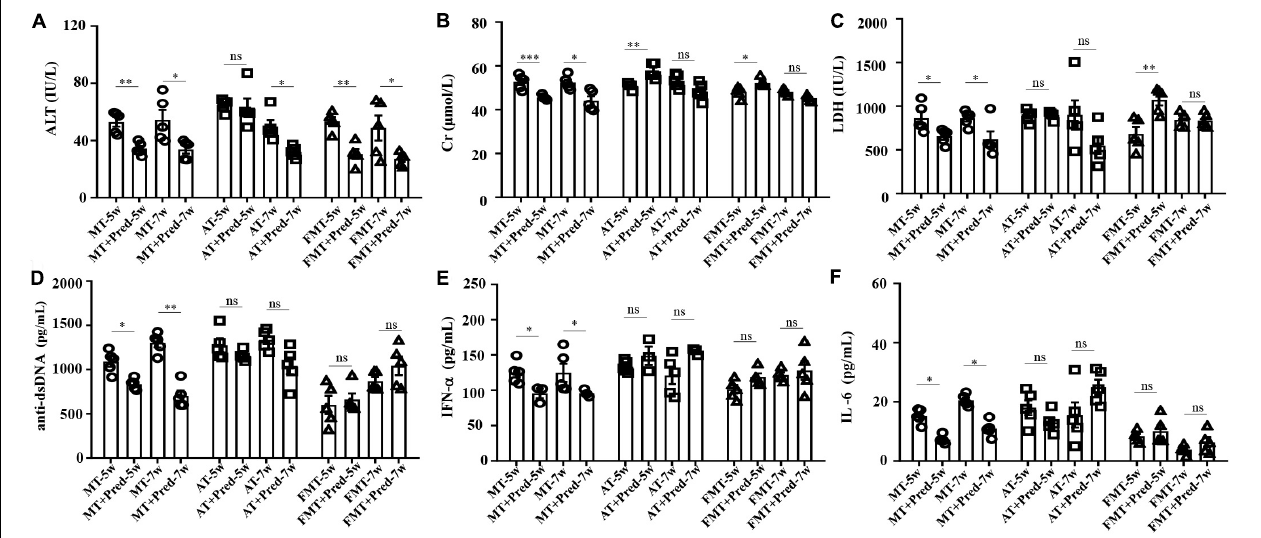
FIGURE 4 | Prednisone-induced alterations in serum levels of alanine aminotransferase activity (A) , creatinine (B) , lactate dehydrogenase activity (C) , anti-double stranded DNA antibody (D) , interferon- α (E) and interleukin-6 (F) in MRL/lpr mice from three groups. NC, The C57/BL6 mice treated with PBS solution from 6 to 9 weeks old; MT, the MRL/lpr mice treated with PBS solution from 6 to 9 weeks old; AT, the MRL/lpr mice treated with antibiotics from 6 to 8 weeks old and PBS solution from 8 to 9 weeks old; FMT, the MRL/lpr mice treated with antibiotics from 6 to 8 weeks old and fecal microbiota transplantation from 8 to 9 weeks old. “ ∗∗∗ ” represents p < 0.001; “ ∗∗ ” represents p < 0.01; “ ∗ ” represents p < 0.05; “ns” represents no significant difference. Pred, prednisone. N =